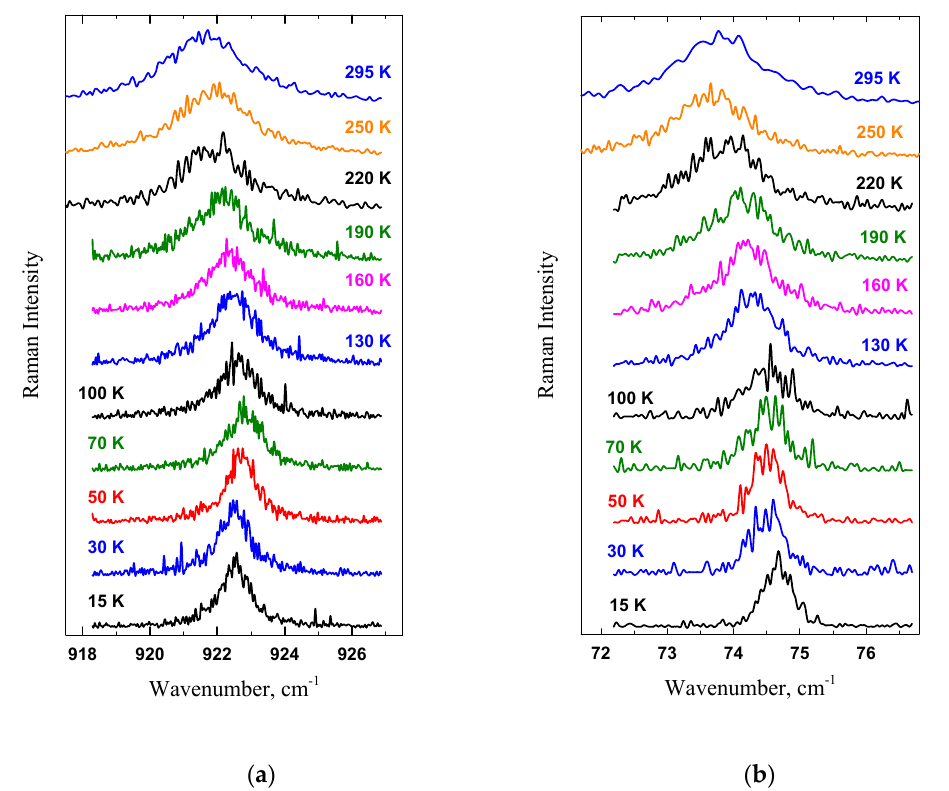
Figure 2. Temperature-dependent Raman spectra of A g ( ν 1 ) internal Raman mode ( a ) and B g ( ν ext ) lattice mode ( b ) in SrWO 4 crystal.